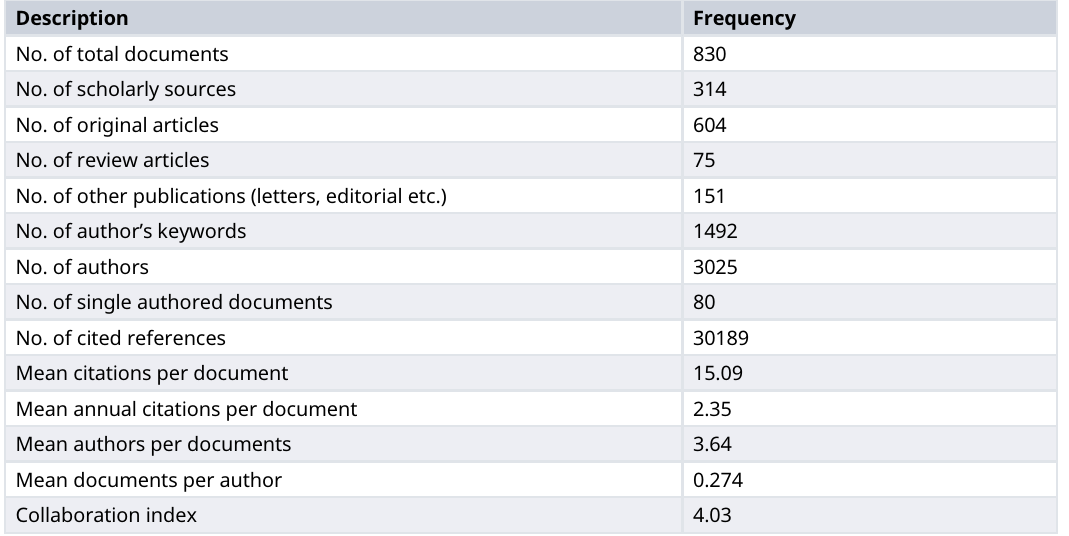
Table 1. Summary of the bibliographic